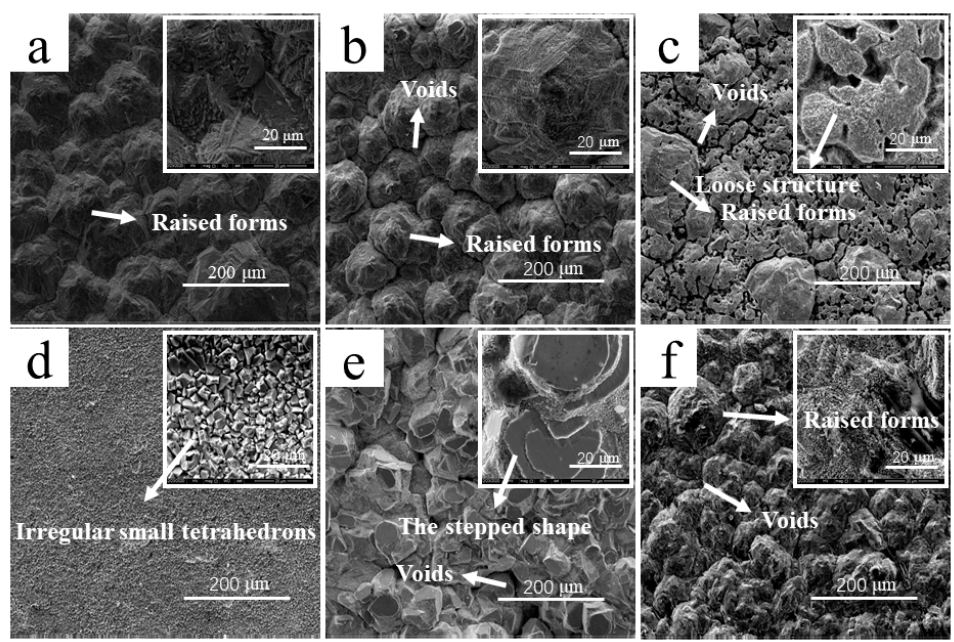
Figure 6. The microscopic morphology of the cathode copper with different Cd 2+ concentrations in the first stage of the cyclone electrowinning process: ( a ) 0 g/L, ( b ) 2 g/L, ( c ) 3 g/L, ( d ) 4 g/L, ( e ) 5 g/L, and ( f ) 6 g/L.